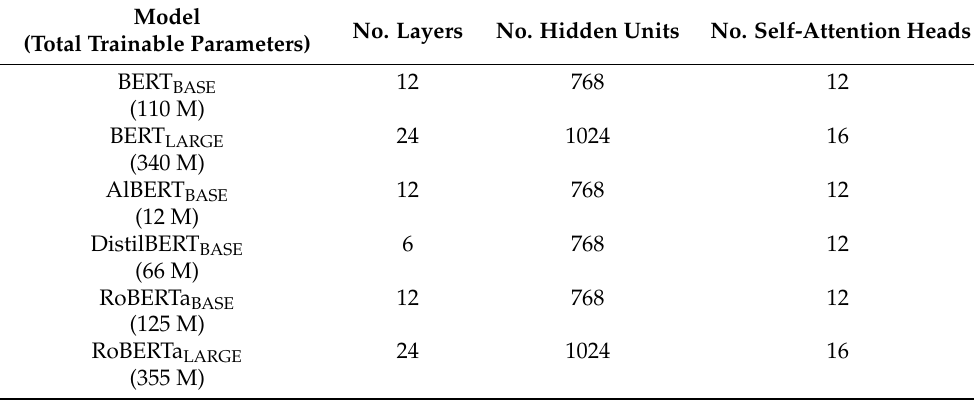
Table 4. Model Comparison (table adapted from [11]). Model No. Layers No. Hidden